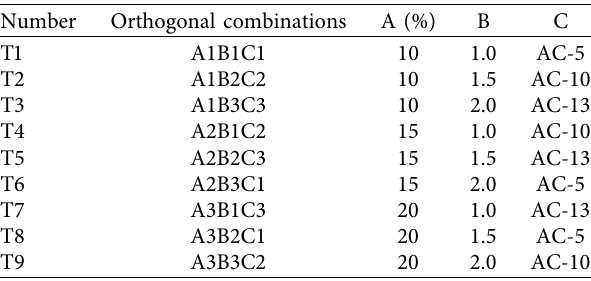
Table 8: Orthogonal experimental